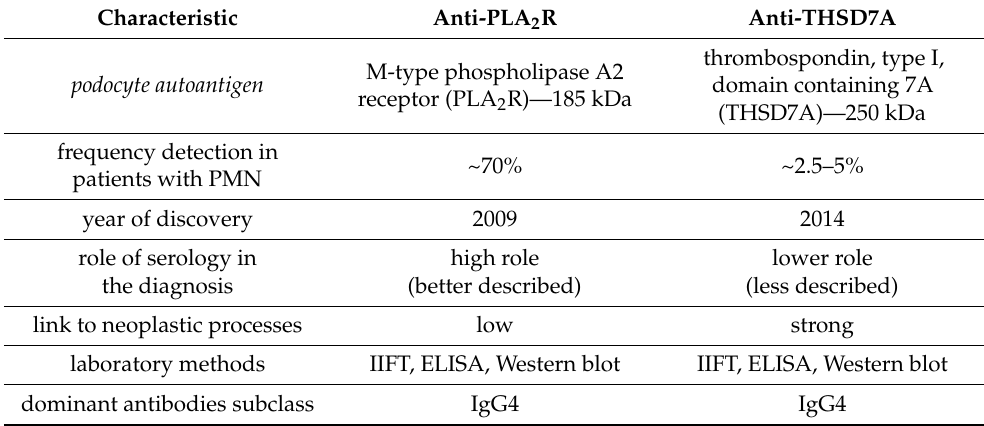
Table 2. A comparison of anti-PLA 2 R and anti-THSD7A [10,34,36–41,43,47,48]. Characteristic Anti-PLA 2